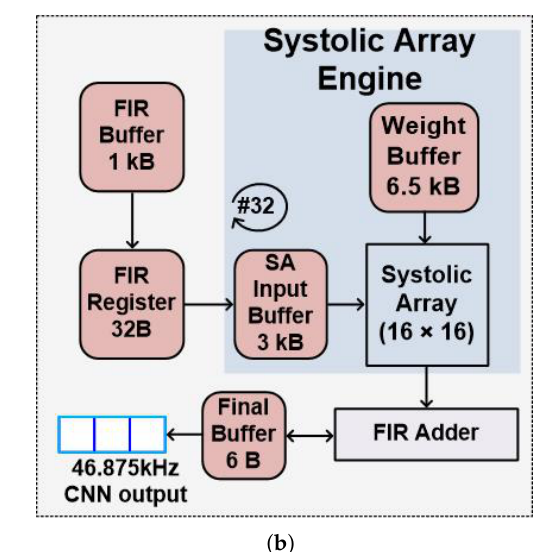
Figure 12. Proposed CNN model accelerator implementation ( a ) layer operation and ( b ) 512-tap FIR filter